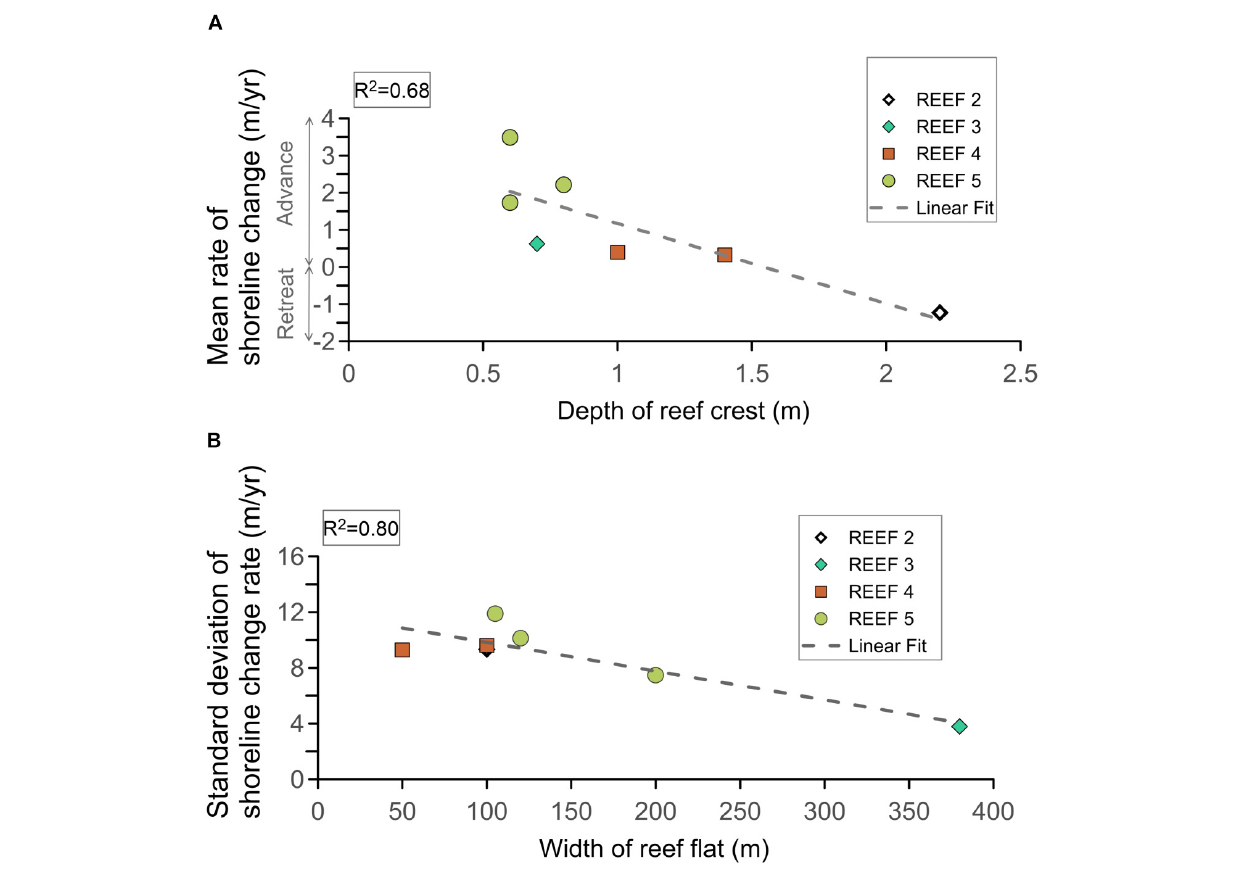
FIGURE 7 | R -squared values of reef geometry and shoreline changes: (A) Mean rate of shoreline change against depth of reef crest. (B) Standard deviation of the shoreline change rates against width of reef flat. The colors in both panels indicate the different reef systems. The dashed line represents a linear regression line fitted by least squares. R 2 is the square of the Pearson linear correlation coefficient, tested at 95% confidence